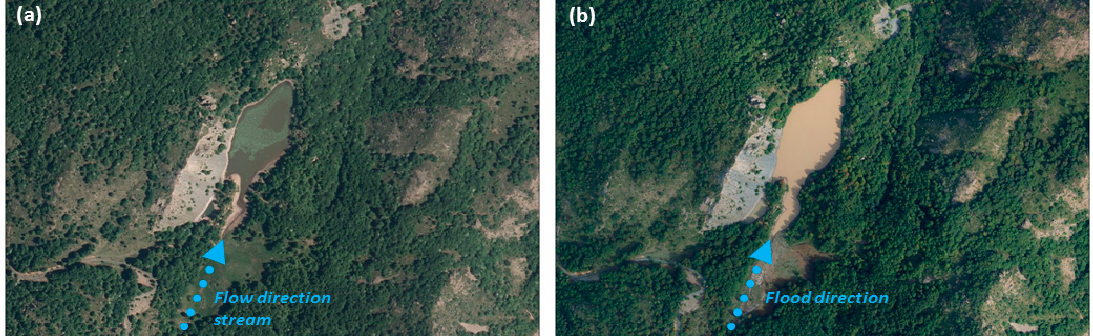
Figure 8. Satellite imagery before ( a ) and after ( b ) the high-discharge flood in September 2015. Note the solid transport that has long hit Lake Bino (IT 4020008 site code). Note the occurrence of Nuphar lutea during summer.